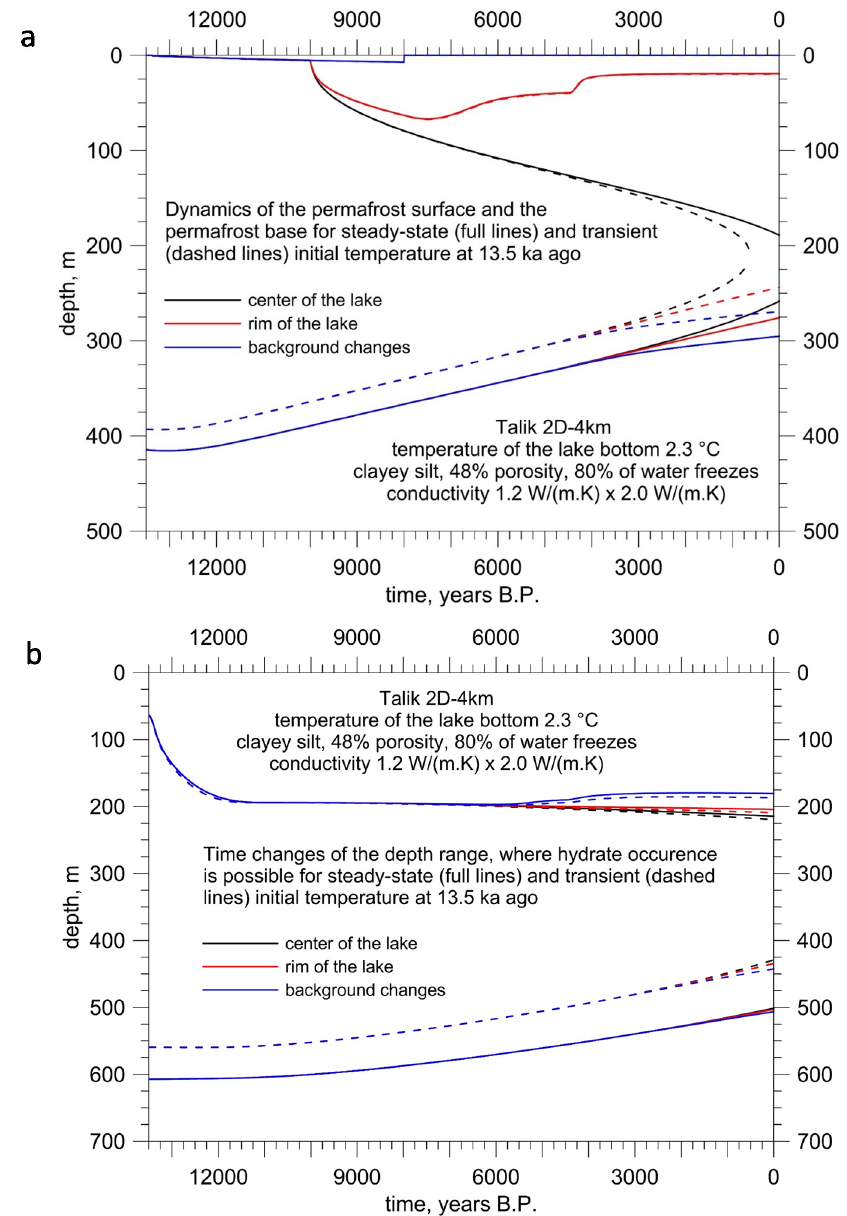
Figure 8. Model results for the steady-state and transient initial surface temperature forcing beginning at 13.5 ka ago for both the permafrost boundaries ( a ) and the GH boundaries ( b ). The transient T – z profile used was obtained by solving the 1-D problem for the first 75 ka of the 100 ka glacial cycle, the mean temperature of which is − 12.5 (an average of − 15 °C for the 75 ka long cold part and temperatures between − 6 °C and − 2 °C for the remaining 25 ka of interglacial, following Taylor et al. [1]. As a result, the simulation started by moving quickly from − 12.5 °C to − 15 °C and followed by slower temperature changes during the subsequent 75 ka. In Figure 8 we show the temporal dynamics of permafrost and that of the GH in the 48% porosity clayey model both for the steady-state and transient initial T – z profiles. The model with an initially transient T – z profile predicts shallower permafrost and gas hydrate layer bases, several tens of meters shallower than those obtained using a steady state temperature profile. They also predict times that are 1–2 ka earlier for the decay of permafrost below the lake than doe the steady state temperature